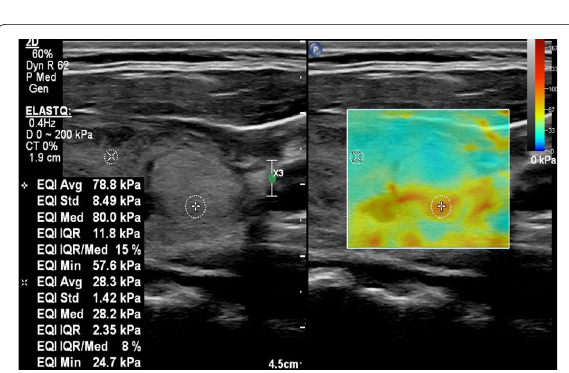
Fig. 4 A 16-year-old male patient with FNAB-proven focal nodular hyperplasia. Transverse scan for right lobe of the thyroid gland performed by linear probe. On the right side of the figure, grayscale US shows a hyperechoic nodule with a well-defined margin. On the left side of the figure, SWE displays a heterogeneous color elasticity signal with peripheral high SWE areas